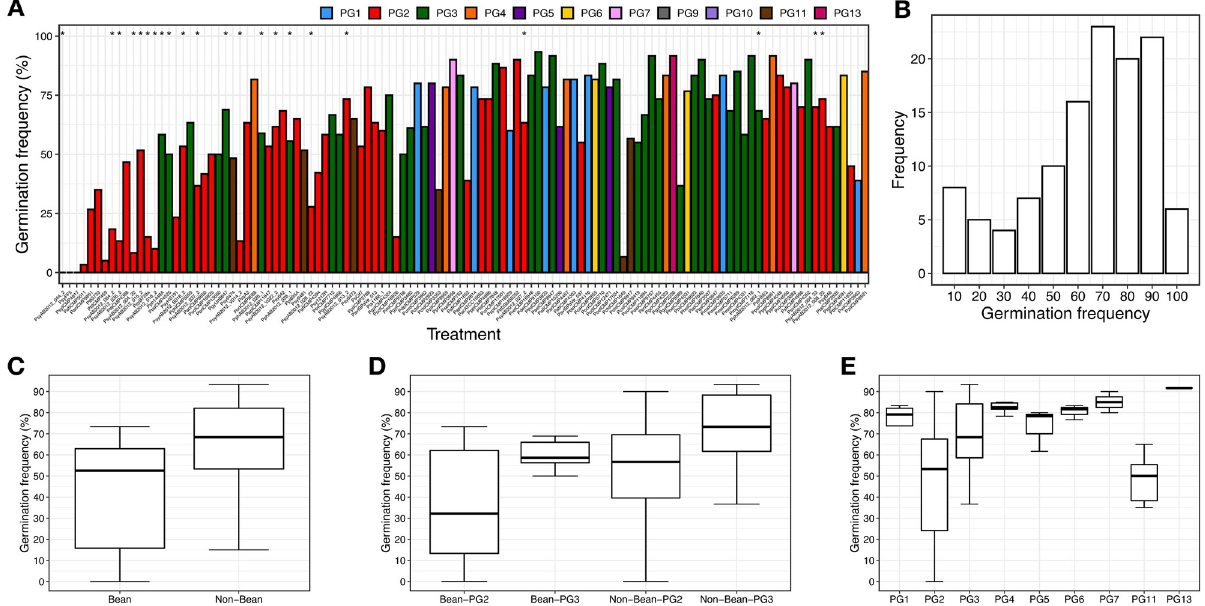
Fig 5. Germination frequencies by host and phylogroup. (A) Boxplots showing the germination frequencies frequency for 121 screened P . syringae strains with strains presented in the same manner and order as in Fig 6. (B) Frequency plot of germination for the 121 screened strains. Distribution of germination frequencies for (C) bean verses non-bean isolates, (D) bean and non-bean isolates stratified by phylogroup, and (E) virulence values stratified by phylogroup (PG) for the set of 121 screened strains.